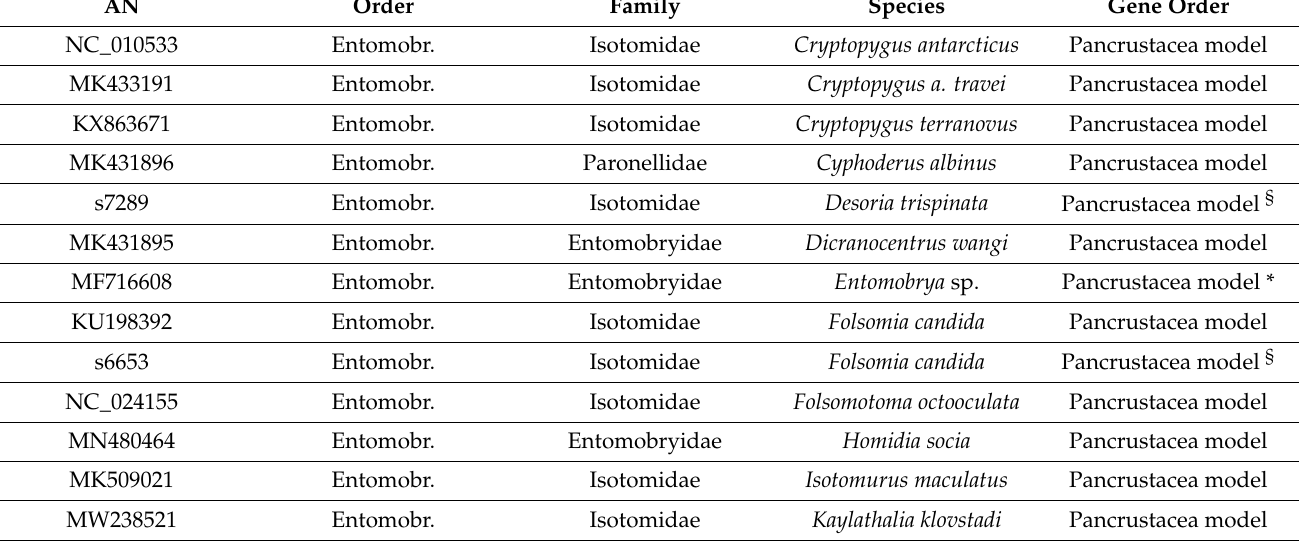
Table 1. Species used in the current study. Gene order column asterisks (*) indicate a compatible assignment to the already described gene order. Section signs ( § ) indicate manual curated sequences originally obtained by [20]. Order names are abbreviated. Further information is available in Table S3. See GenBank for reference of downloaded